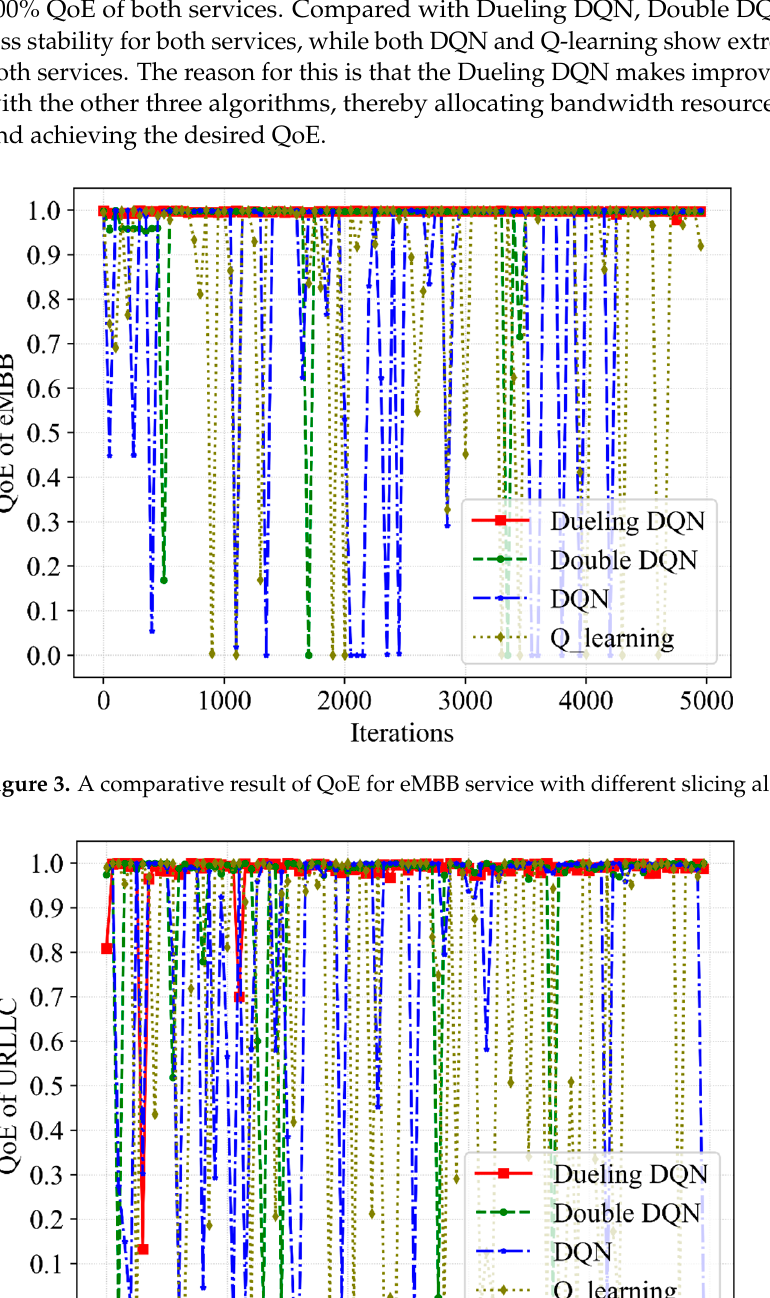
Figure 5. A comparative result of SE with different slicing algorithms.